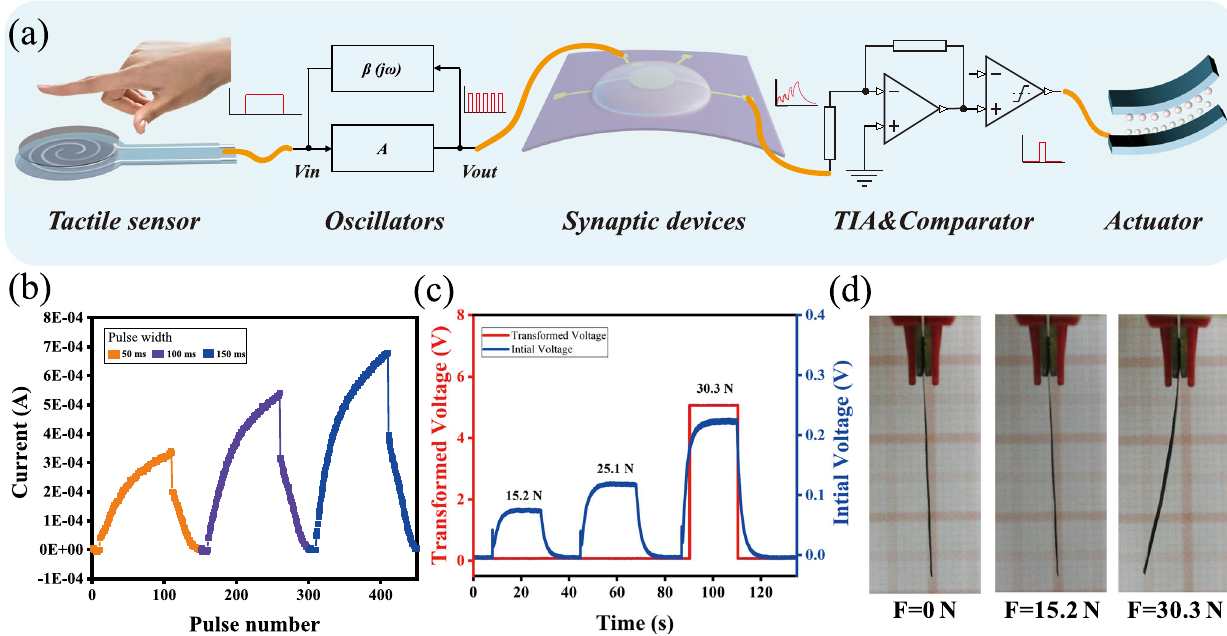
Fig. 5 The instant feedback functions of the arti fi cial system. a The schematic of the arti fi cial somatosensory system composing of several main components. b EPSC response of the synaptic transistor triggered by different gate voltage spikes. c The output signal of the TIA (blue curve) and the comparator (red curve) when the arti fi cial system is under different pressure. d The optical photograph of the arti fi cial muscles when the arti fi cial system is under different